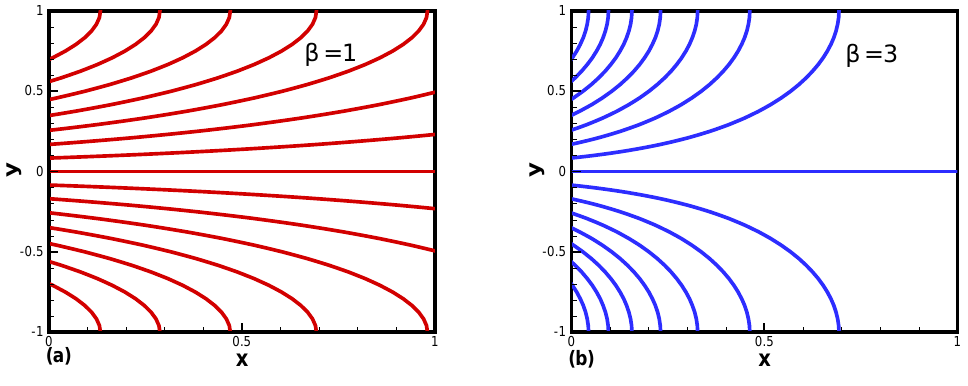
Figure 14. Streamlines behavior for water-based copper nanoparticle when ( a ) β = 1 and ( b ) β = 3 and other parameters are R e = 1, δ = 0.2, φ = 0.05, and γ =